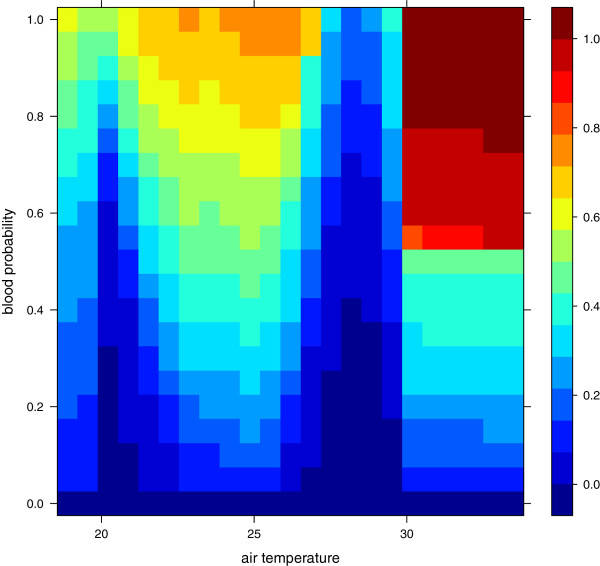
Fraction of An. arabiensis as a function of air temperature and probability of finding a blood meal. The fraction of An. gambiae s.s. is one minus the fraction for An. arabiensis.